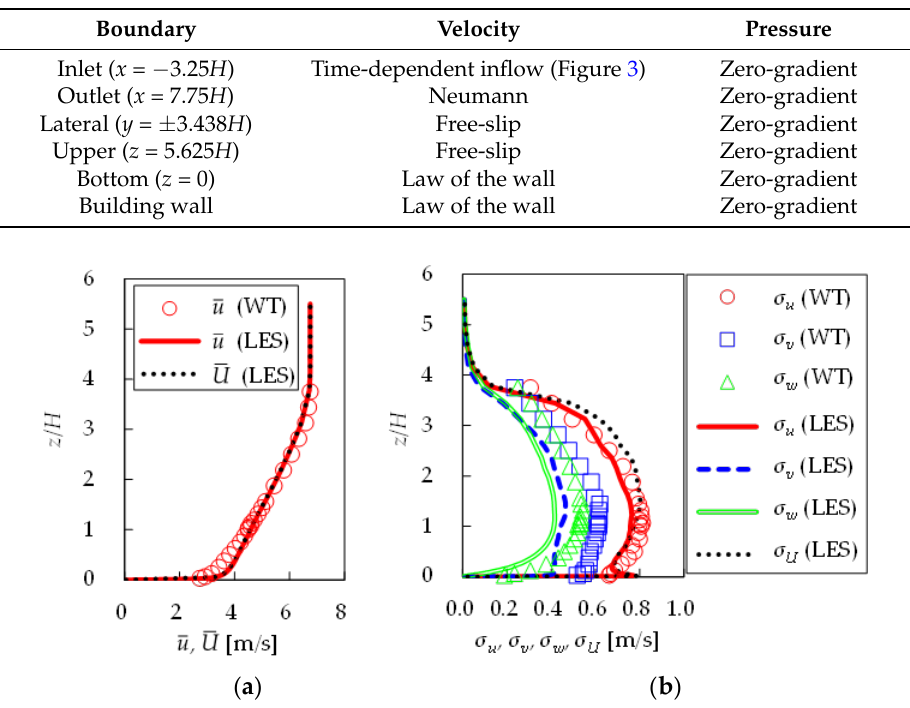
Figure 3. Vertical profile of time-dependent inflow. “LES” represents the LES results from the present study, and “WT” represents the wind-tunnel observations from Meng and Hibi [20]. ( a ) Streamwise mean velocity, u ̅ , and horizontal mean velocity, U ̅ ; ( b ) Standard deviations of velocity components in the streamwise direction, σ u , in the lateral direction, σ v , in the vertical direction, σ w , and in the horizontal direction, σ U .